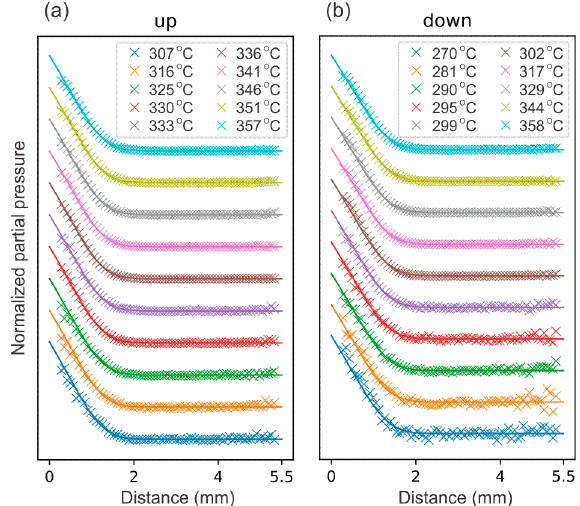
Figure 3. Comparison between the experimental CO 2 NPPs (crosses) and the simulated CO 2 NPPs (solid lines) for a range of catalyst temperatures from the temperature ramp-up ( a ) and -down branches ( b ) in Figure 2. Note that the first data point (cross) corresponds to a measured signal at 0.3 mm above the surface.